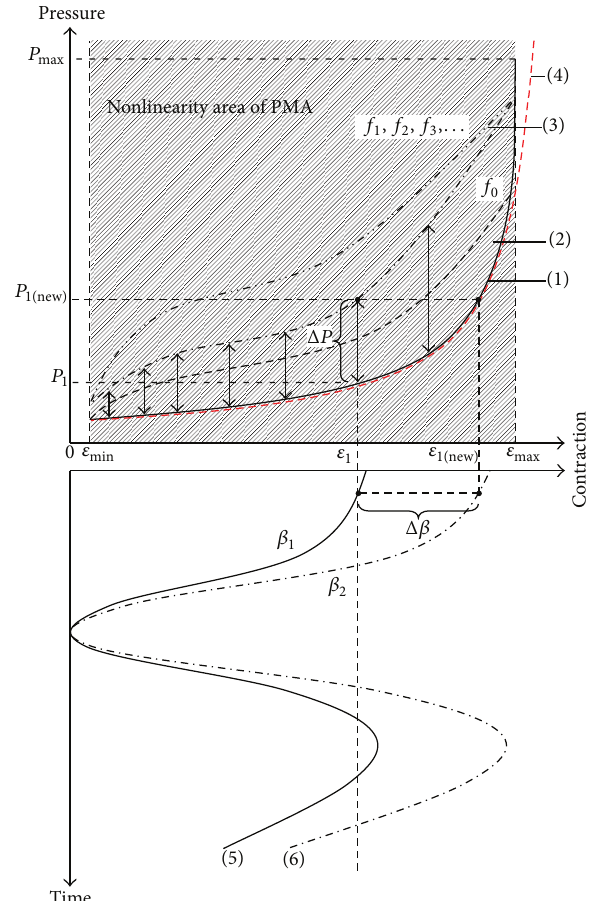
Figure 8: Cocontraction model control scheme’s strategy, where (1) PMA static model of pressure versus contraction at zero load condition; (2) PMA hysteresis model at zero load (𝑓 0 ) condition; ,𝑓 , 𝑓 ,...) condition; (4) PMA (3) PMA hysteresis model at load (𝑓 1 2 3 model using 6th-order polynomial equation; (5) contraction input pattern for the antagonistic mono- and bi-articular actuators; (6) controlled contraction input patterns after the controls of the muscle activation level (𝛽) ; Δ𝑃 is the sudden increase in pressure due to the PMA nonlinearity; and Δ𝛽 is the increase in muscle activation